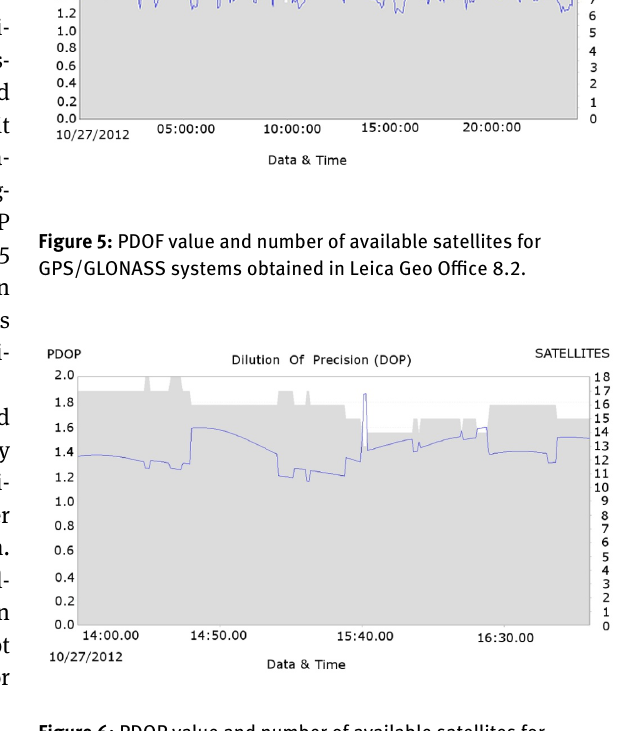
Figure 6: PDOP value and number of available satellites for GPS/GLONASS systems in optimal time interval obtained in Leica Geo Oflce